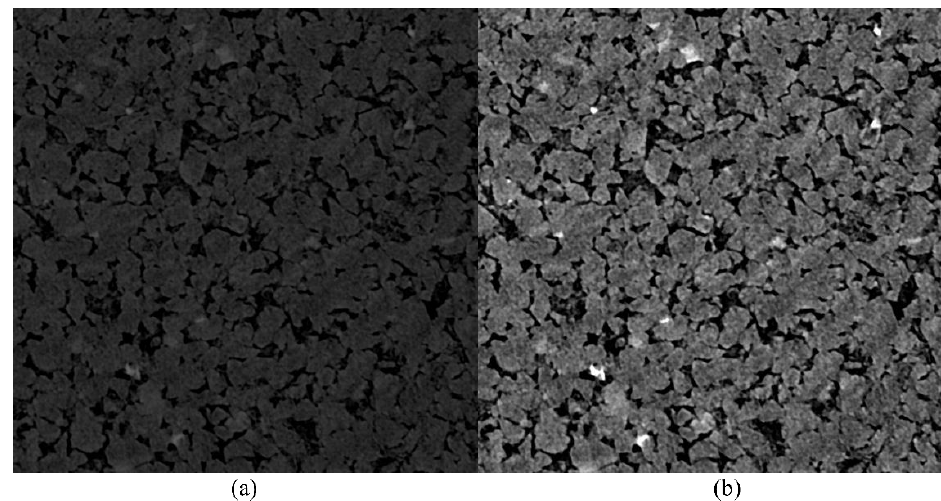
Figure 3. Grayscale images before ( a ) and after ( b ) applying the contrast enhancement and noise reduction filters.